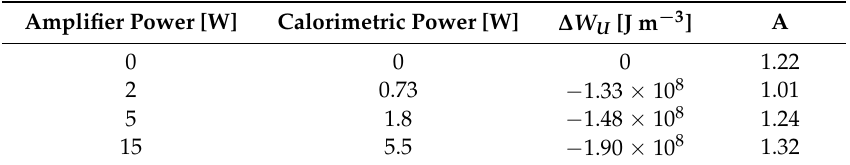
Table 1. ∆ W U and the pre-exponent A, determined by fitting Equation (6) to the experimental data shown in Figure 6 for different ultrasound powers. It was assumed γ = 31.0 mNm -2 and that the supersaturation ratio is unaffected by ultrasound. The pre-exponent A, obtained using Equation (3) for the absence of ultrasound, is also shown for